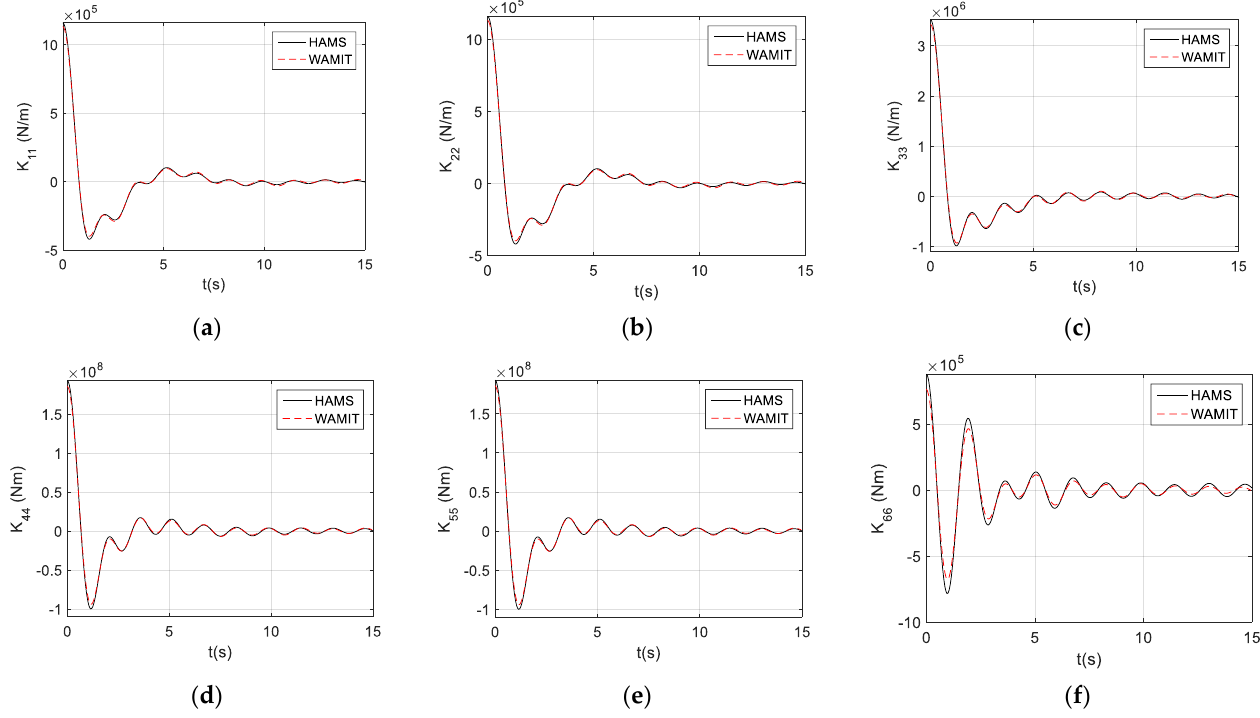
Figure 8. The conventional impulse functions: ( a ) 𝐾 11 ; ( b ); 𝐾 22 ; ( c ) 𝐾 33 ; ( d ) 𝐾 44 ; ( e ) 𝐾 55 ; ( f ) 𝐾 66 .